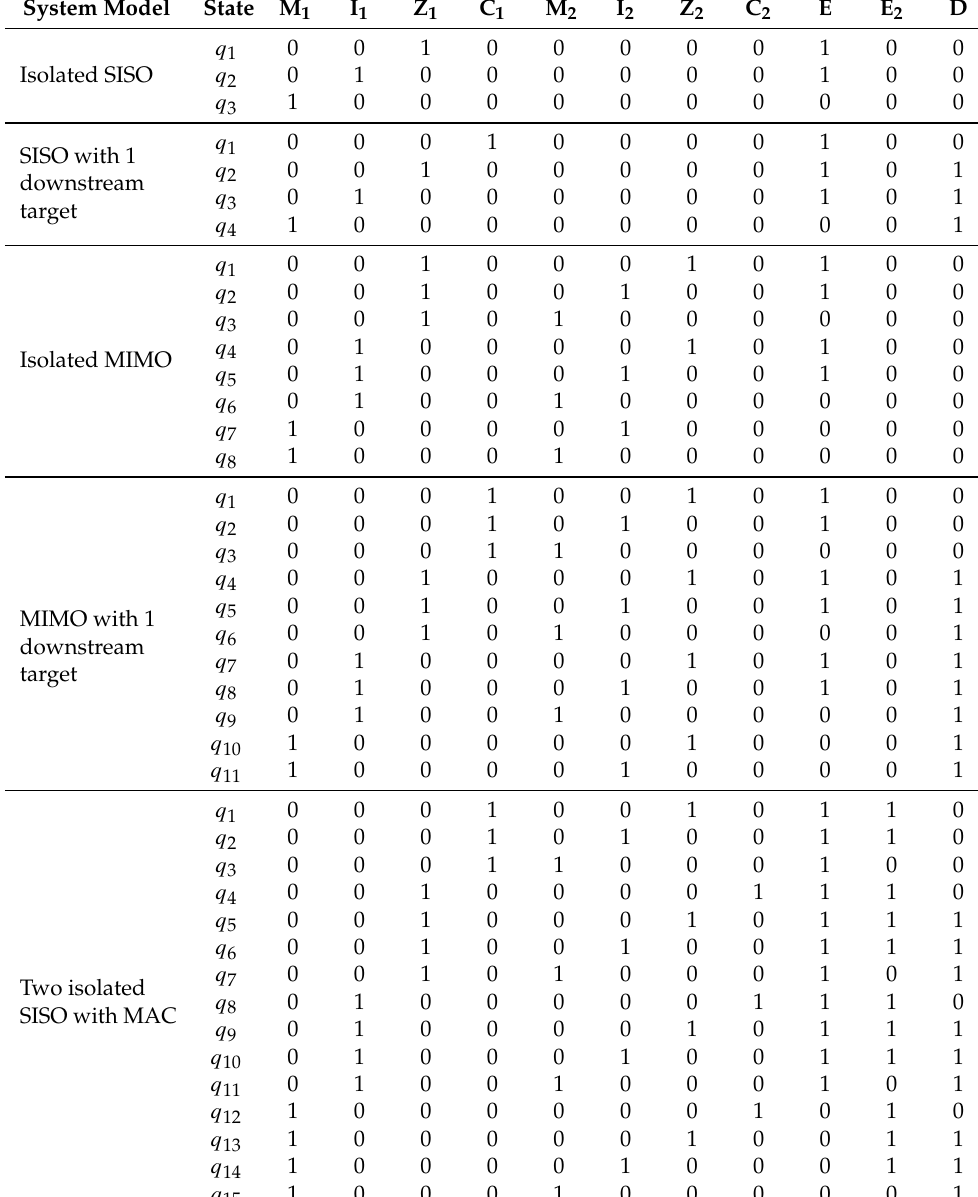
Table A2. Microstates of the systems when I tot System Model